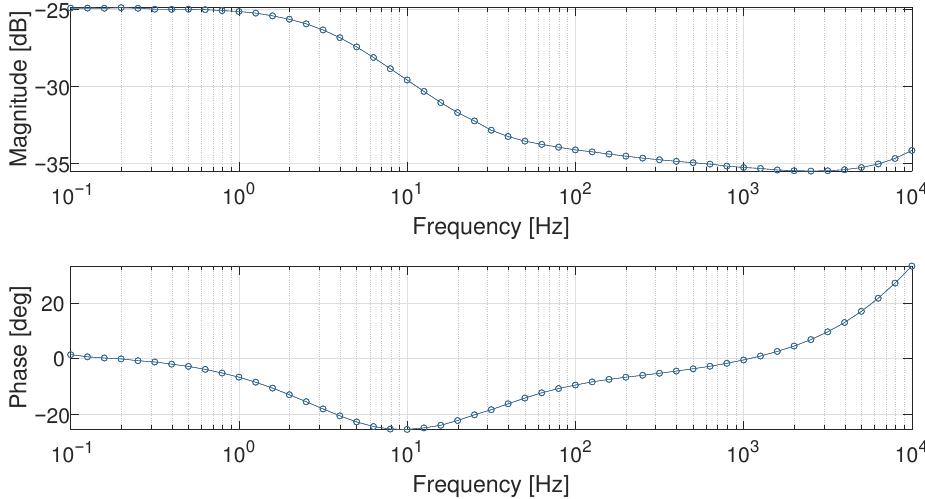
Figure 5. Bode diagram at the working point of 1A in the frequency range [0.1; 10,000]